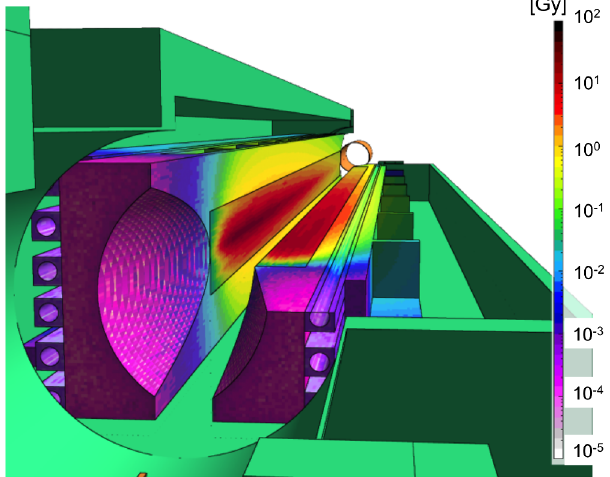
FIG. 8. Map of dose deposited by all the impacting proton bunches on the TCT jaws, obtained by FLUKA simulations, for Case 1.